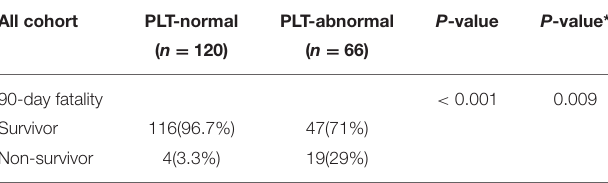
TABLE 2 | Outcomes of PLT-normal group and PLT-abnormal group.